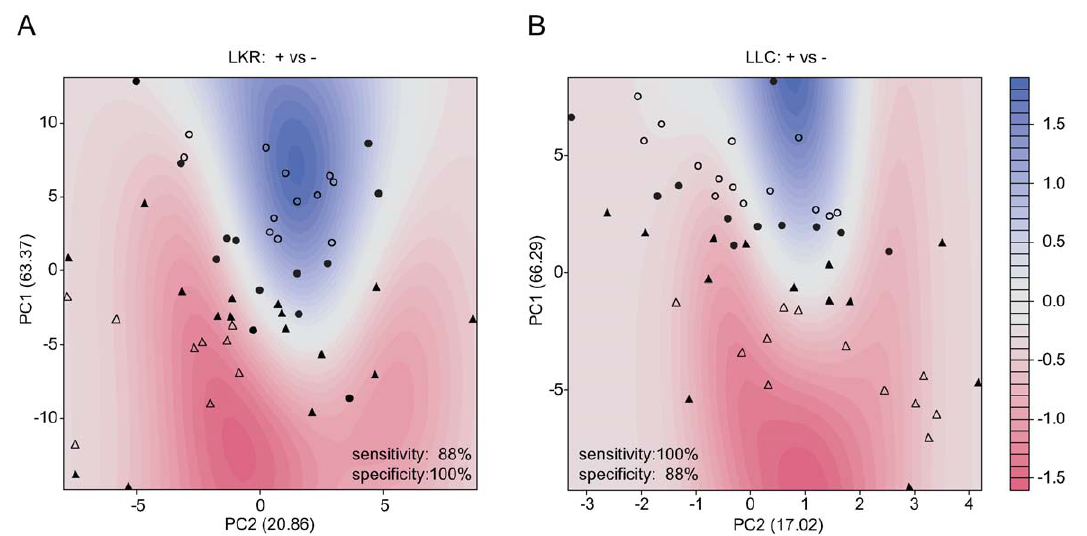
Figure 3. Separation of tumor and placebo groups based on PCA scores using SVM. Separation of tumor and placebo groups by Principle Components Analysis (PCA) and its boundary determination by Support Vector Machine (SVM) are shown in A (LKR) and B (LLC). Circles represent individuals of tumor groups and triangles represent individuals of placebo groups (Support vectors: solid circles and triangles). The background contour color, ranging from red to blue, indicates the class probability for different regions of the